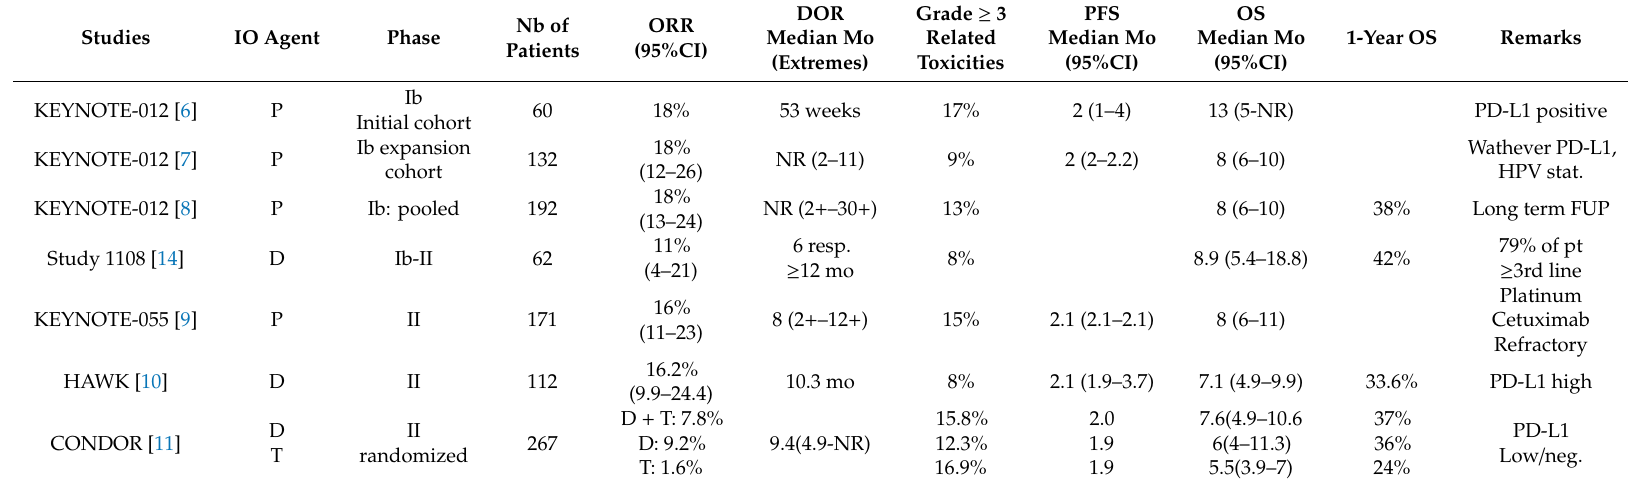
Table 1. Phase Ib-II in R / M pretreated patients (platinum